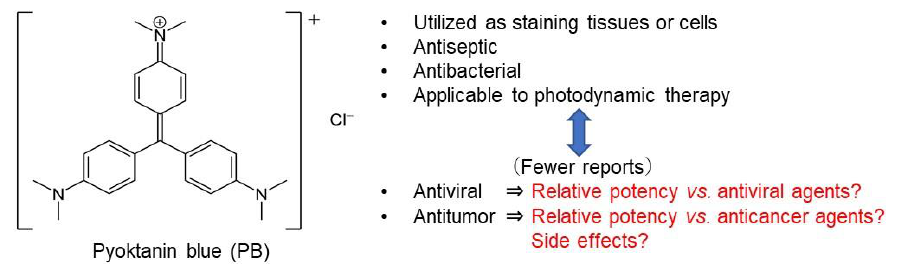
Figure 1. Structure of pyoktanin blue (PB) and design of the present study. On the other hand, publications on the antiviral activity and antitumor activity of PB have been fewer compared with publications on its antibacterial activity. PB showed an- tiviral activity against Nipah, Hendra virus, their pseudotypes, vesicular stomatitis virus, and human parainfluenza virus type 3, except influenza A virus [13], while another group reported the opposite result, finding that PB inactivated the influenza A virus [14]. As for anticancer activity, PB induced cell death in oral precancerous cells through ROS produc- tion, suppressed the progression of DMBA-induced oral precancerous lesions [15], and prompted apoptosis in a human breast cancer cell line [16]. Although many anticancer drugs induce adverse effects, such as oral mucositis, peripheral neurotoxicity, and extrav- asation at the injection site [17], most of previous studies of PB do not present information of its chemotherapeutic index (safety margin), possible adverse effects, and comparative performance against appropriate antiviral and antitumor agents. In the present study, an- titumor activity, neurotoxicity, and antiviral activity of PB were re-evaluated by chemo- therapeutic indices and in comparison with appropriate positive controls in order to es- tablish the most effective administration schedule of PB.